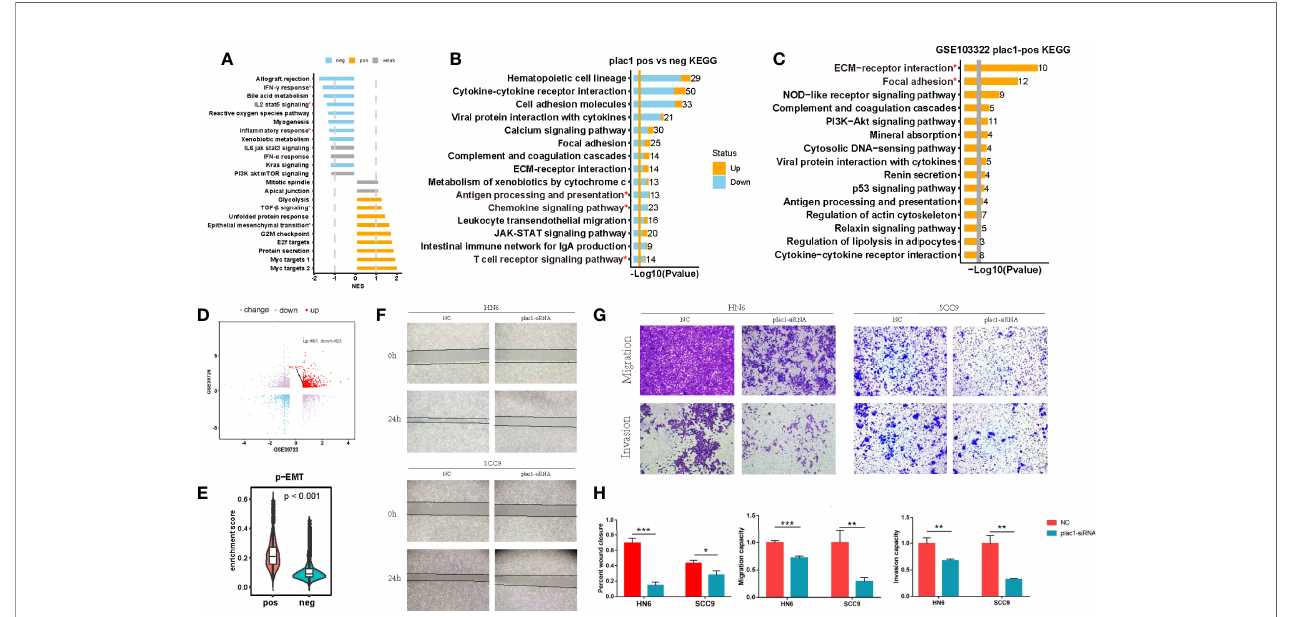
FIGURE 2 | Plac1 was related to the invasive biological characteristics of head and neck squamous cell carcinoma (HNSC). (A, B) Gene Set Enrichment Analysis of hallmarks (A) and Kyoto Encyclopedia of Genes and Genomes (KEGG) analysis (B) in plac1-positive and plac1-negative samples from The Cancer Genome Atlas-HNSC database. (C) KEGG pathway gene sets in plac1-positive cells from the single-cell dataset GSE103322. (D) Plac1 was among the upregulated genes according to the invasion selection assay in both GSE39723 and GSE39725. (E) Difference in the enrichment score of the p-EMT signature in plac1-positive and plac1-negative cells from the single-cell dataset GSE103322. (F – H) Images of wound healing assay (F) and Transwell assays for migration and invasion (G) in negative control and plac1 knockdown group. The quantitative analysis of wound closure, migration ability, and invasion ability is shown in (H) . * p < 0.05, ** p < 0.01, *** p <